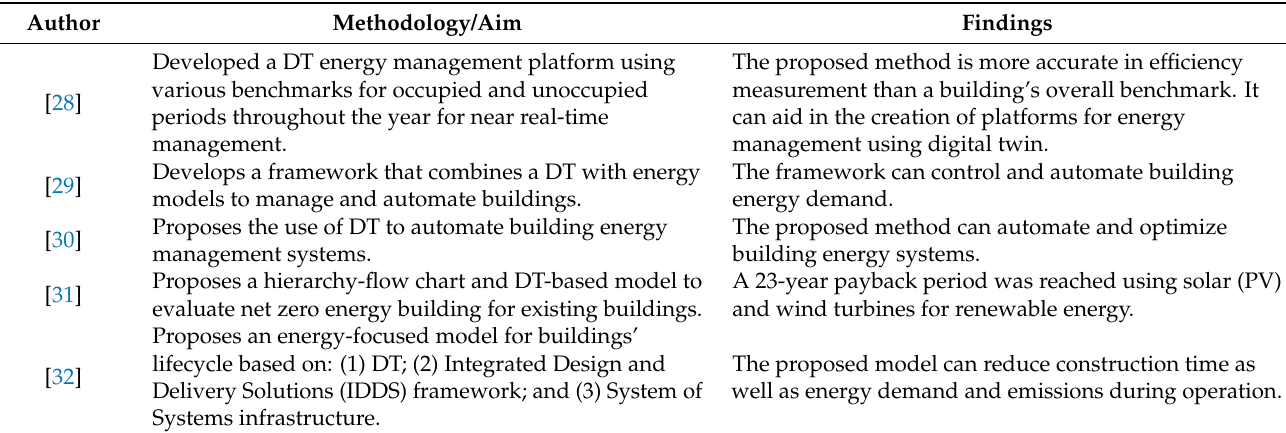
Table 2. Digital Twin for Energy